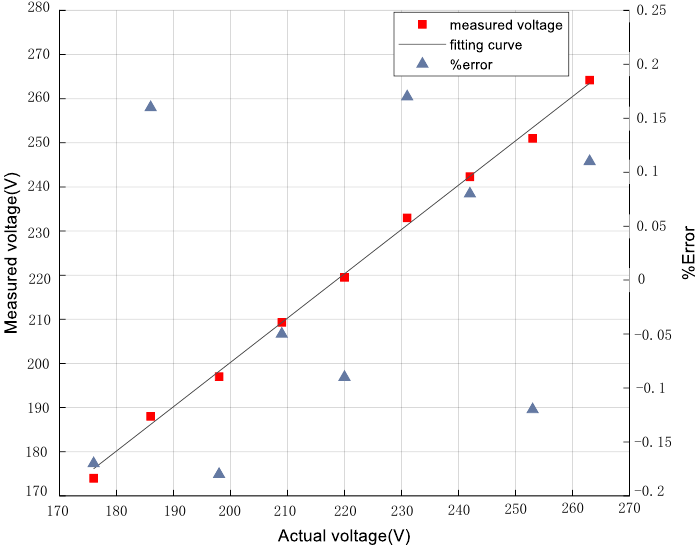
Figure 15. Measurement linearity and accuracy.